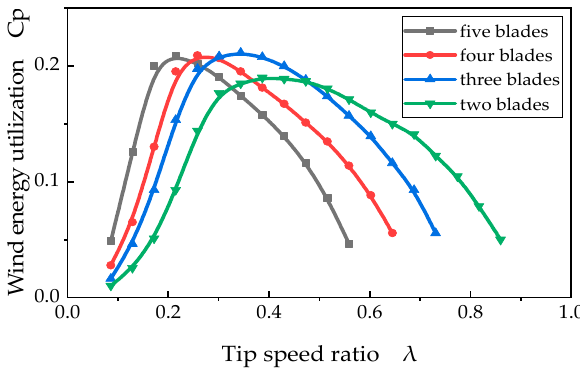
Figure 12. Comparison curve of wind energy utilization when the number of blades is two, three, four and five.